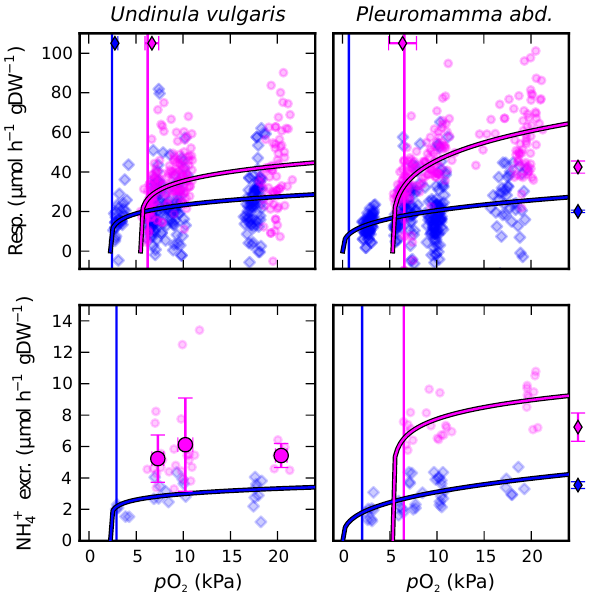
Figure 6. Weight-specific respiration and ammonium excretion rates of Euphausia gibboides and Euphausia mucronata at differ- ent oxygen partial pressures and temperatures (CO 2 -plus and CO 2 - minus treatments combined). Magenta symbols = 23 ◦ C, Green symbols = 13 ◦ C. Transparent dots represent single measurements. Solid curves indicate the power function fits to the data. Regression coefficients are given in Table 3. Solid vertical lines indicate the re- spective p crit for respiration and ammonium excretion. Horizontal error bars indicate the mean ( ± SD) lethal p O 2 at the given tem- perature for E. gibboides . A power function could not be fitted to the ammonium excretion data for E. gibboides , therefore the mean ( ± SD) excretion rates for the three pre-set oxygen levels (100% air saturation, 50 and 33%) are plotted with vertical errorbars. Respi- ration and excretion rates were standardized to a mean dry mass of 0.1g. Error bars right beside the plots indicate the respiration or am- monium excretion rate ( ± SE) calculated according to Ikeda (2014) for euphausiids (0.1gDW) at the respective